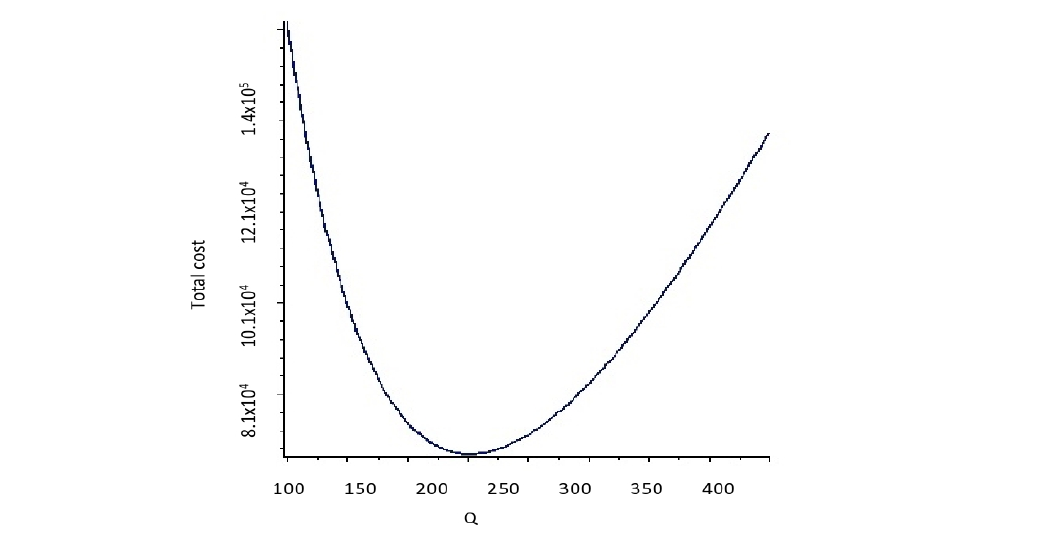
Figure 2. Convexity of the total cost vs order quantity for best case